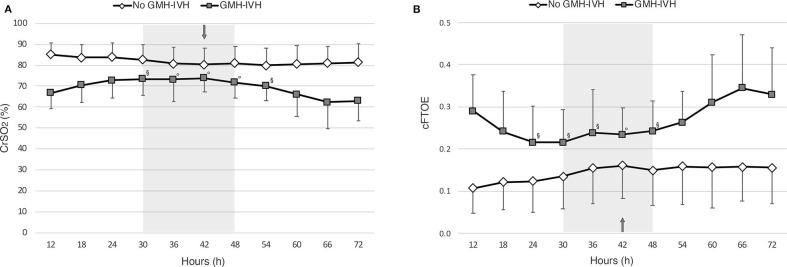
Patterns of cerebral oxygenation (CrSO2,) (A) and of cerebral fractional oxygen extraction (cFTOE) (B), evaluated at 6-hour intervals over the first 72 h of life in infants who developed GMH-IVH (in gray) and those who did not (in white). The arrow indicates the median age at GMH-IVH detection, whereas the gray shadow represents the related interquartile time range. Linear mixed-model regression significances for time*IVH interaction are provided (◦p < 0.01; §p < 0.05).